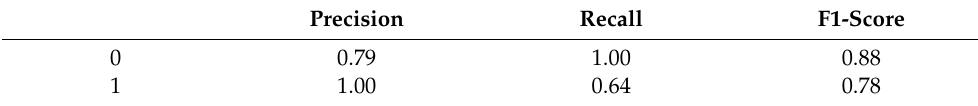
Table 4. Performance Metrics for Training Data.